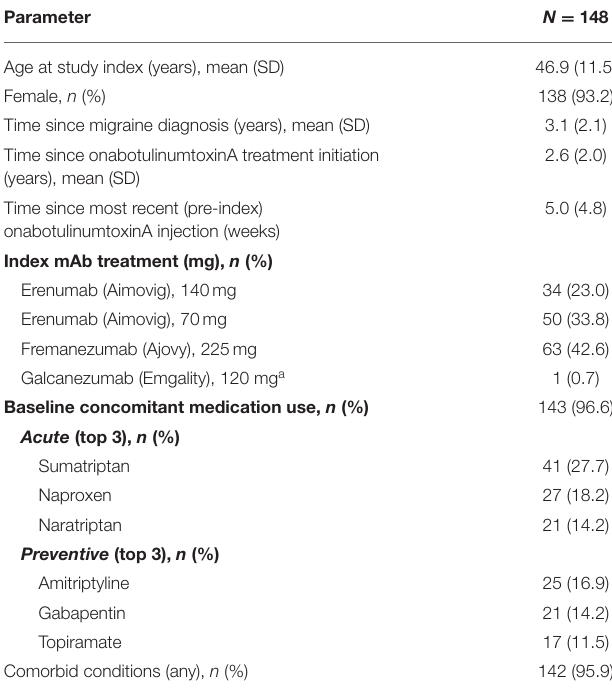
TABLE 1 | Patient demographics and clinical characteristics prior to combination